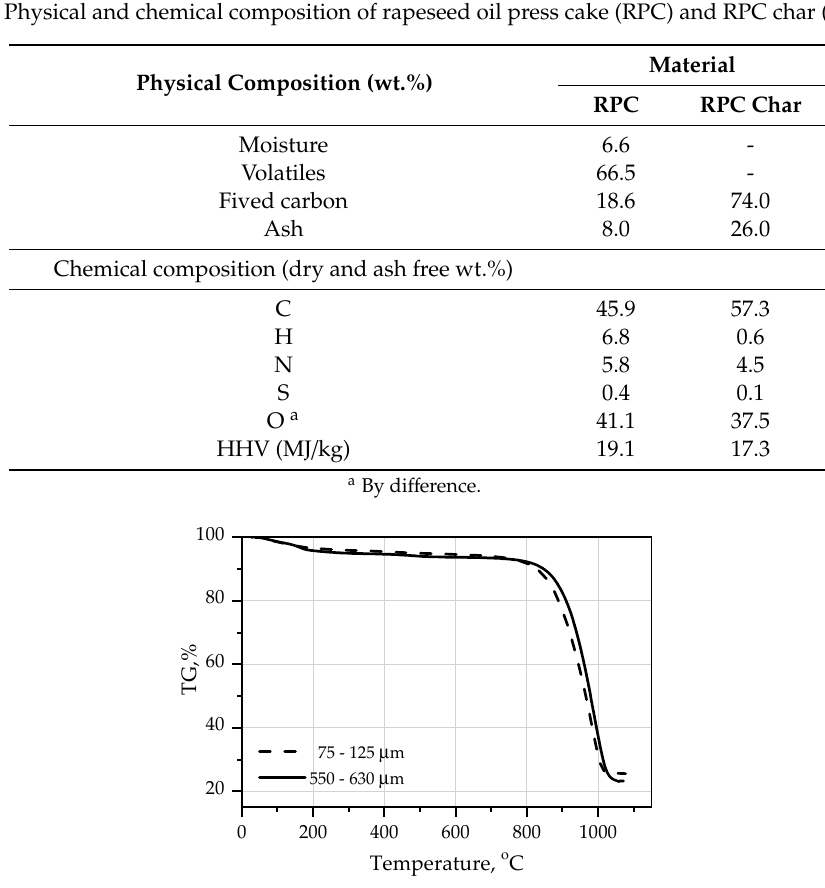
Figure 1. Influence of particle size and temperature on the rate of RPC char gasification in the Ar/CO 2